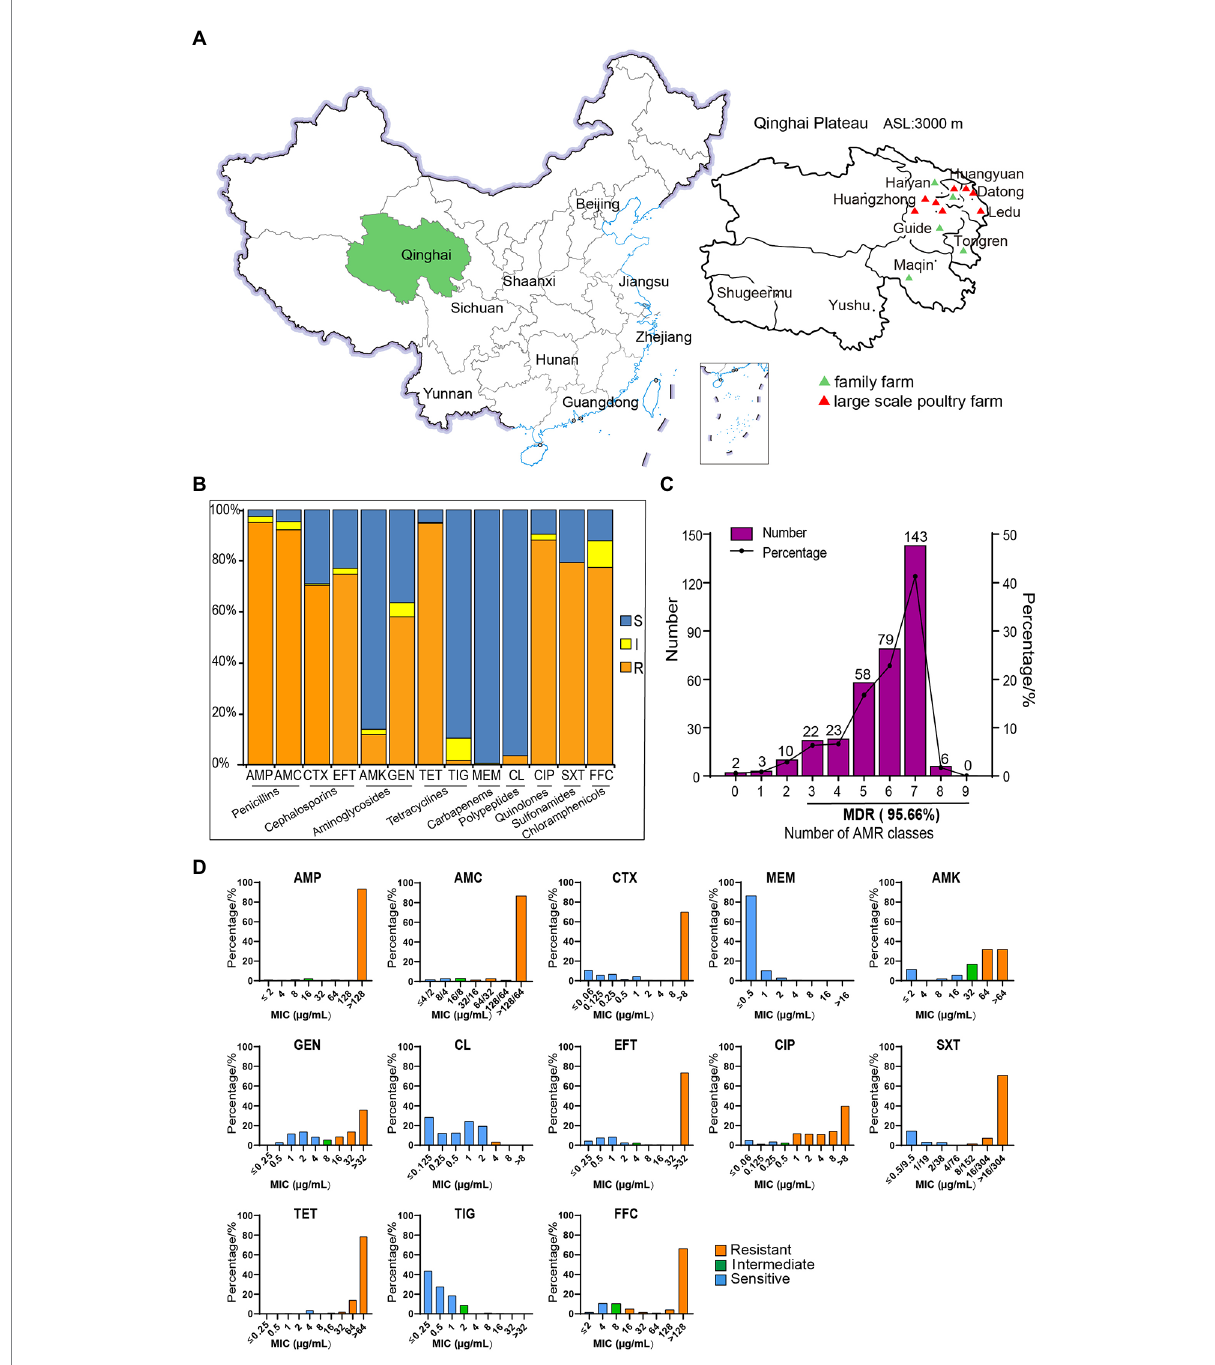
FIGURE 1 The sampling locations and susceptibility test results of 346 strains of Escherichia coli to 13 antibiotics. (A) Sampling areas in Qinghai Province, China. (B) AMR rates of E. coli . (C) The distribution of multidrug-resistant strains. (D) MIC distributions of 13 antibiotics in isolated E. coli